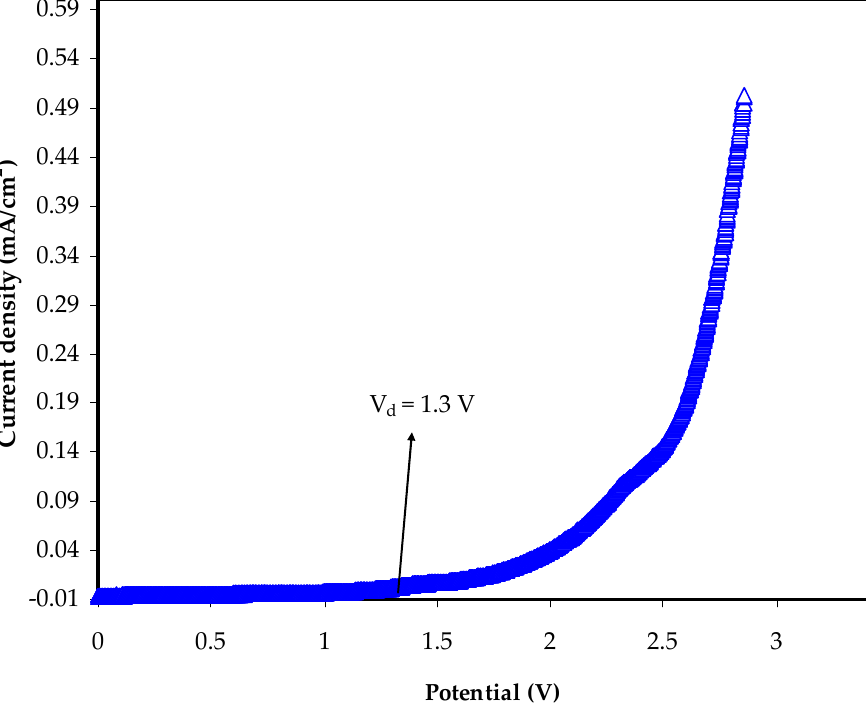
Figure 7. Linear Sweep Voltammetry (LSV) graph of the highest conducting electrolyte at 0.02 V/s.